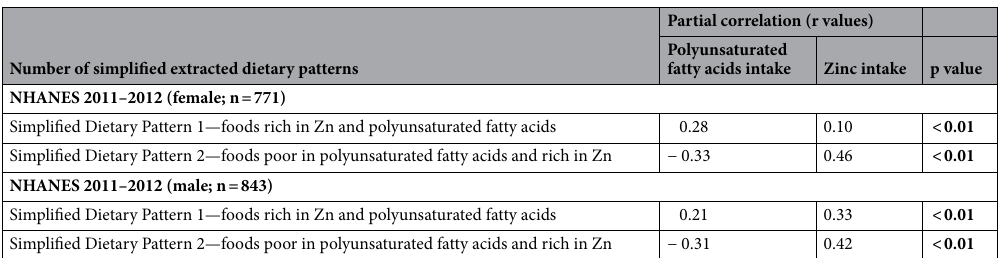
Table 2. Partial correlation between simplified extracted dietary patterns scores and response variables in NHANES 2011–2012. Adjusted for energy intake.